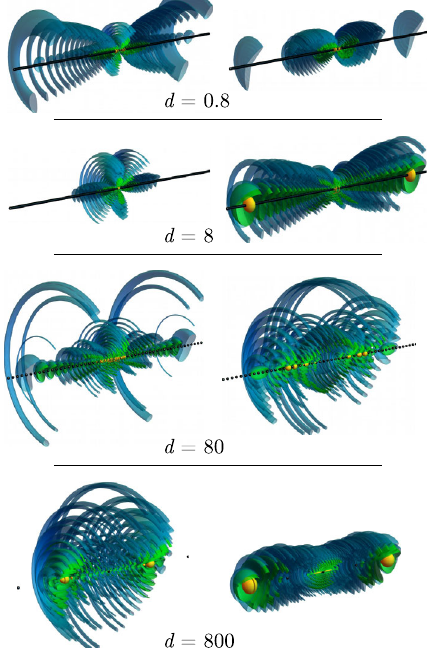
FIG. 3. Electronic densities of a 1D lattice of scatterers for ν ¼ 30 and different lattice spacings d in atomic units. The yellow, green, and blue surfaces correspond to contours at wave function densities spanning factors of 10. The full three- dimensional surfaces are cut away in front to reveal the interior structure. The left-hand column gives the density for the most deeply perturbed state, while the right-hand column gives the density just above the degenerate